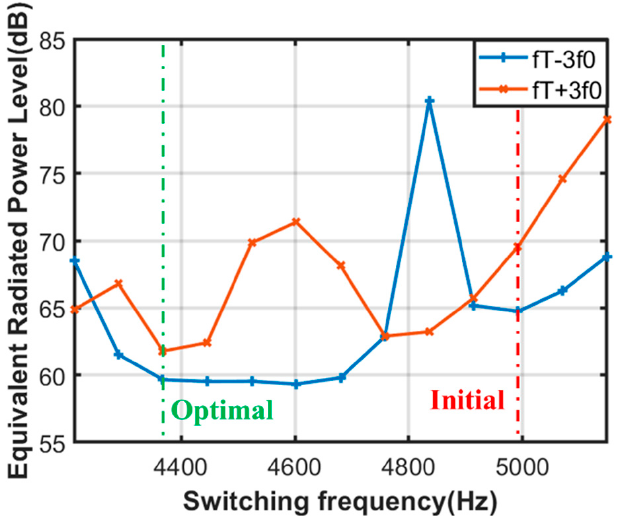
Figure 13. Switching frequency optimization.